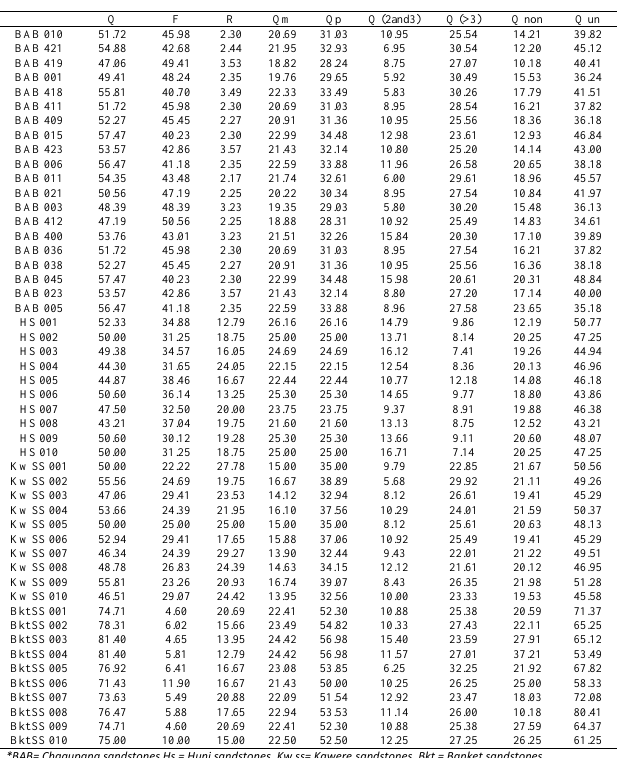
Table 2: Recalculated average modals percentages of the sandstones (BAB= Chagupana sandstones Hs = Huni sandstones, Kw ss=